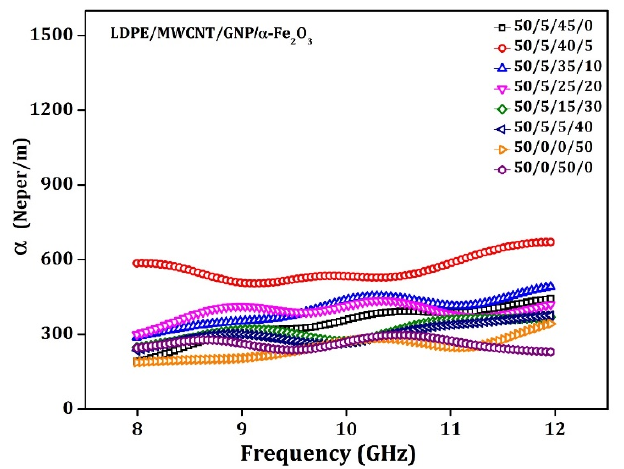
Figure 11. Attenuation constant plots vs. frequency for 3.5 mm thick LDPE: MWCNT: GNP: α‐ Fe 2 O 3 matrix specimen.